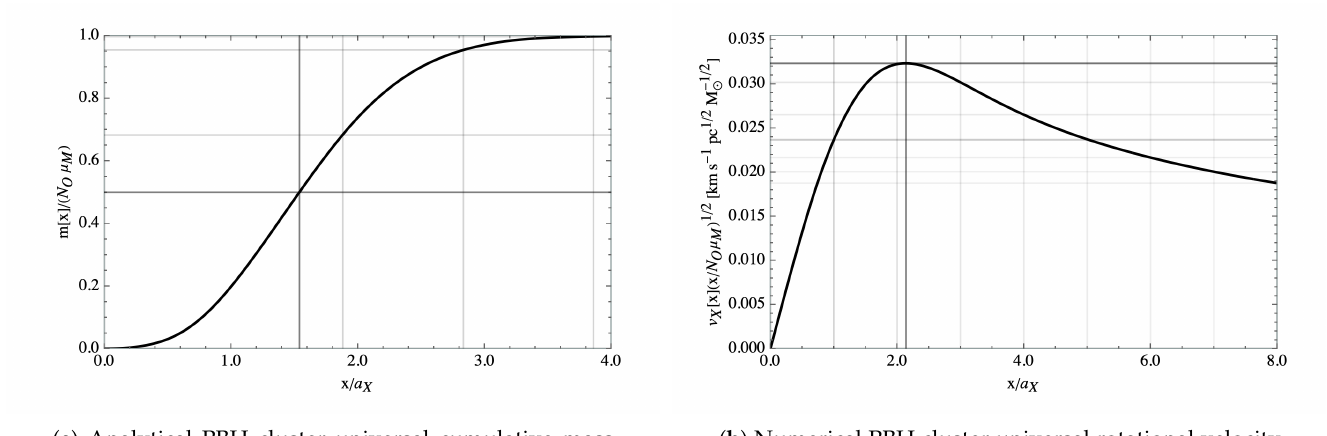
Figure 4. Universal cluster cumulative mass and rotational velocity curves from Table 1, computed for a perfectly traced distribution of PBHs computed from Equation (19) where N O → ∞ . Here, N O , the object mean logarithmic mass, µ m , and cluster mean displacement from the barycentre, σ x . The dark grey line marks the curve value at the radii containing 50% the cumulative mass, while the light grey lines do so for 68%, 95% and 99% the cumulative